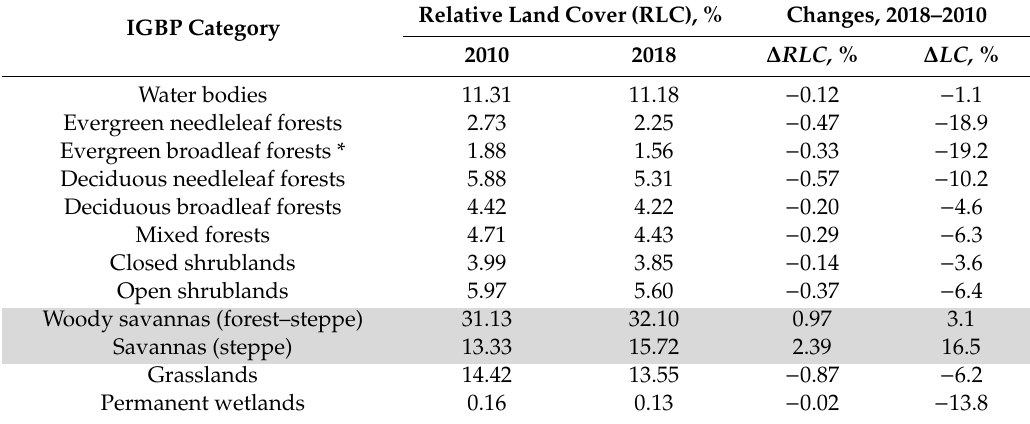
Table 1. The MCD12C1 land cover, as a percentage of the total studied area, inside the territory of Lake Baikal basin, in 2010 and 2018. The IGBP category system of land cover was used. The gray-shaded box around woody savannas and savannas highlights the essentially increasing values of these